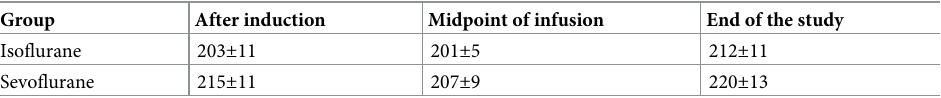
Table 3. The heart rate (HR, beats/min) among different time points in two groups (mean ± SD).